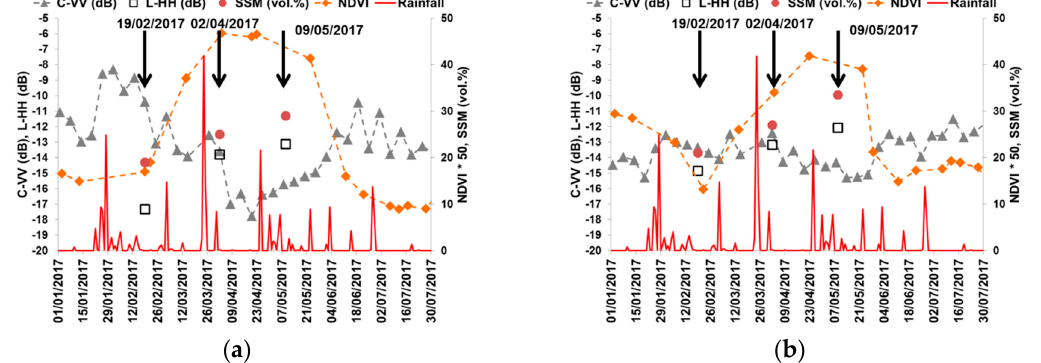
Figure 4. Temporal variation of the SAR signal in the L and C bands according to in situ SSM and NDVI. ( a ): wheat reference plot, ( b ): grassland reference plot. To display NDVI and SSM values on the same axis the NDVI-values were multiplied by 50 (for instance, an NDVI-value of 0.8 corresponds to a value of 40 in Figure 4a,b). The vertical lines in red represent the rainfall events.